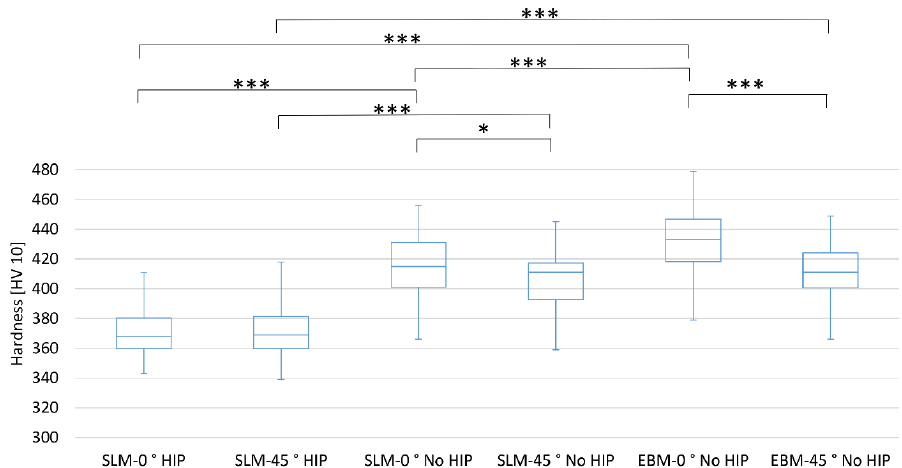
Figure 13. Box plots of the measured hardness HV 10. Box plots give the median value, the interquartile range (IQR: interval between the 25th and 75th percentile, blue rectangle) and the extremum values ( n = 40); statistical significance levels (* p < 0.05; *** p < 0.001). No significant differences from similar other possible manufacturing systems were revealed.